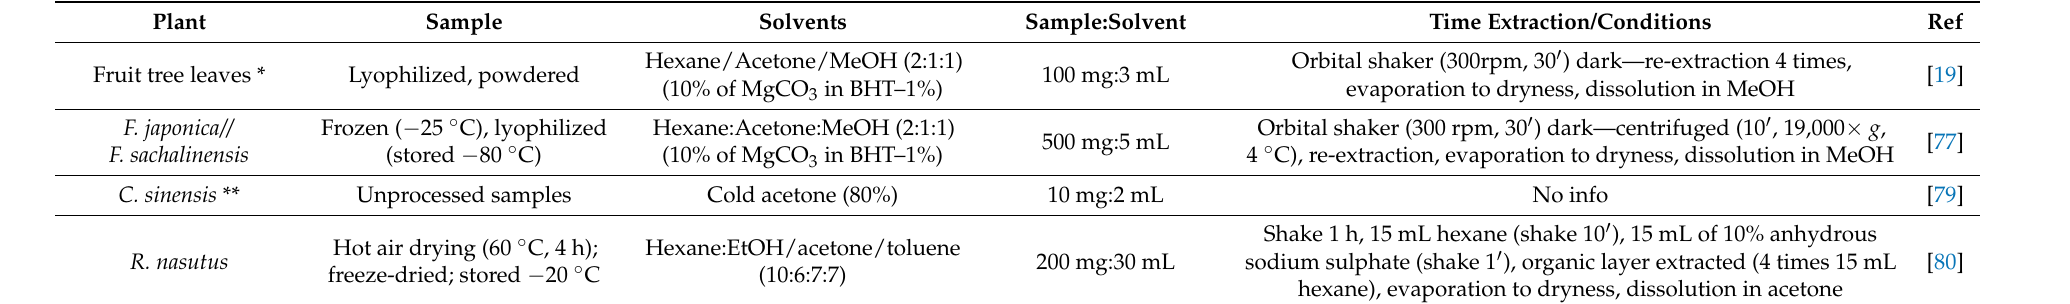
Table 7. Chlorophylls—sample pre-processing and extraction